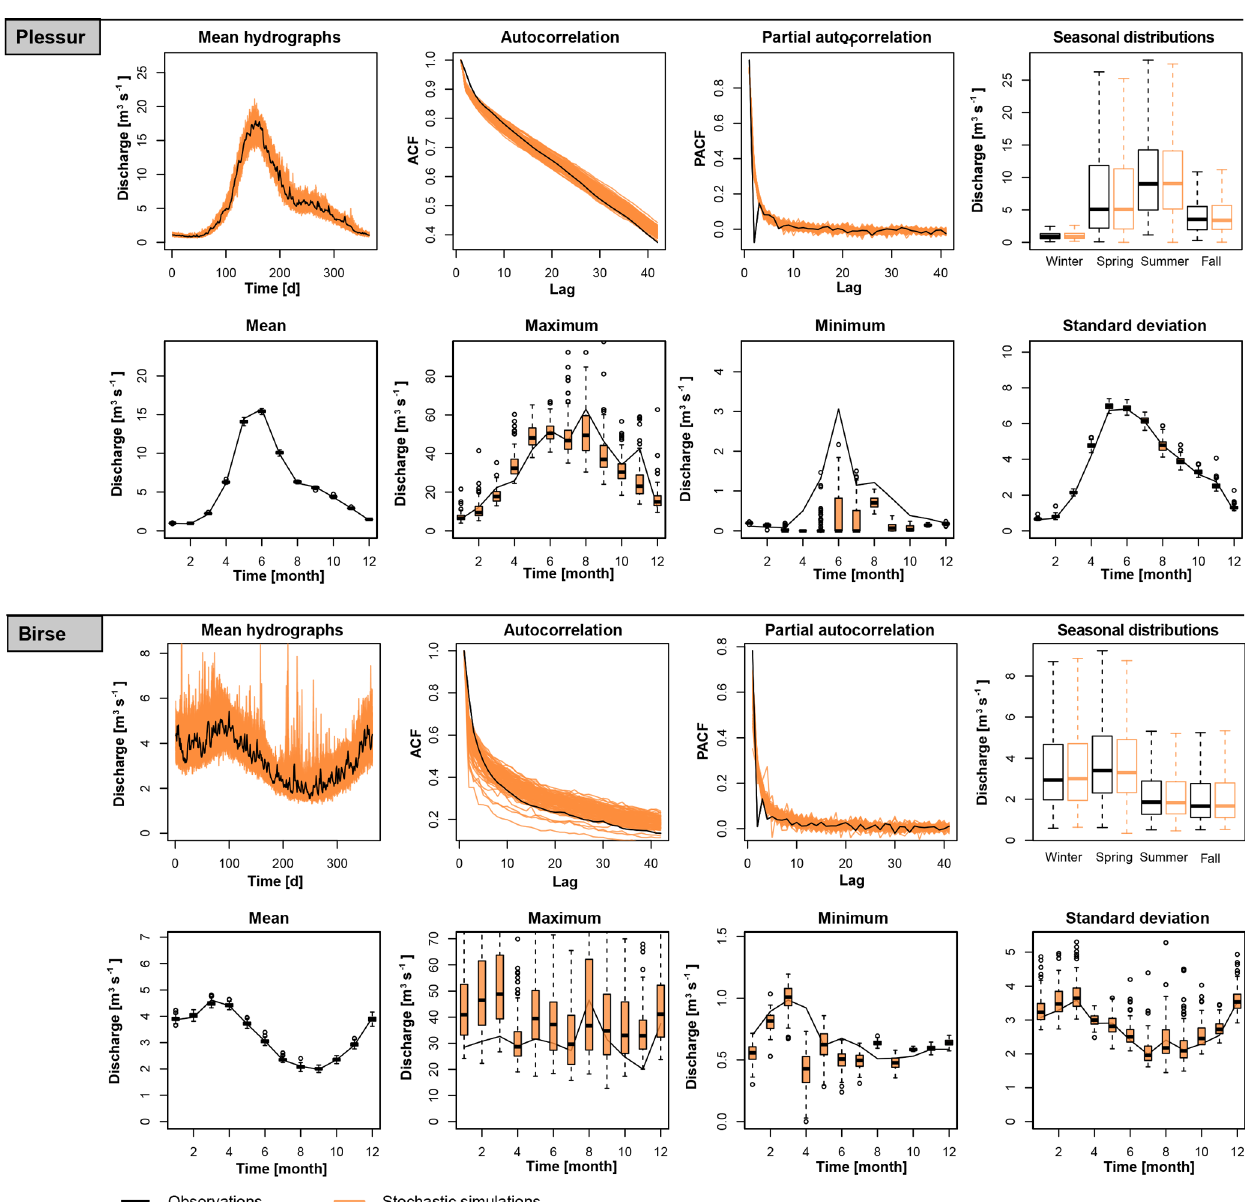
Figure 3. Comparison of observed and stochastically generated time series for the melt-dominated Plessur catchment (upper two rows) and the rainfall-dominated Birse catchment (lower two rows) for the following characteristics: mean hydrograph over 50 years, autocorrelation function, partial autocorrelation function, seasonal distributions, monthly means, monthly maxima, monthly minima, and monthly standard deviations. Black lines represent observations, while orange lines represent